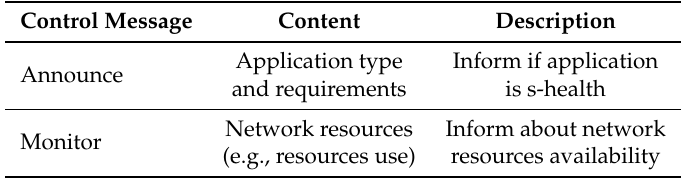
Table 3. PRIMUS control messages.